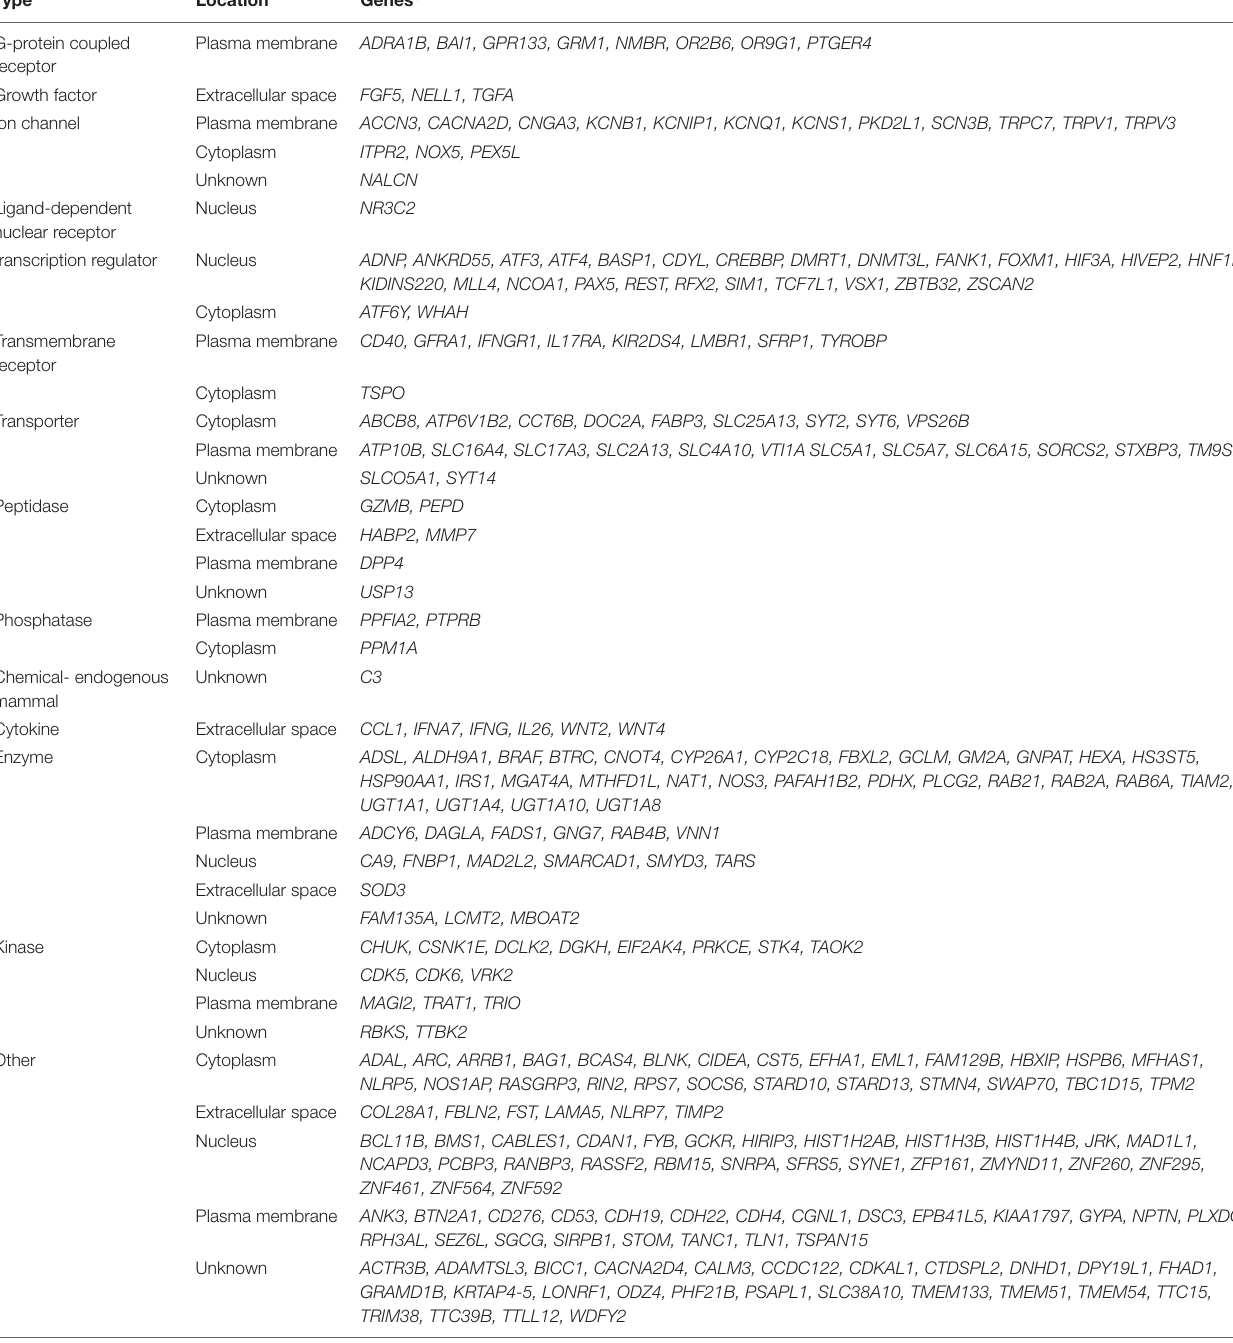
TABLE 2 | Type and location of the 274 seed nodes a selected from the GAIN GWA